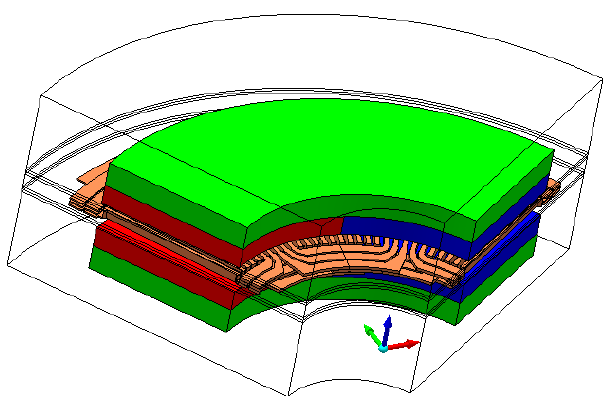
Figure 4. Solving domain model of the prototype.